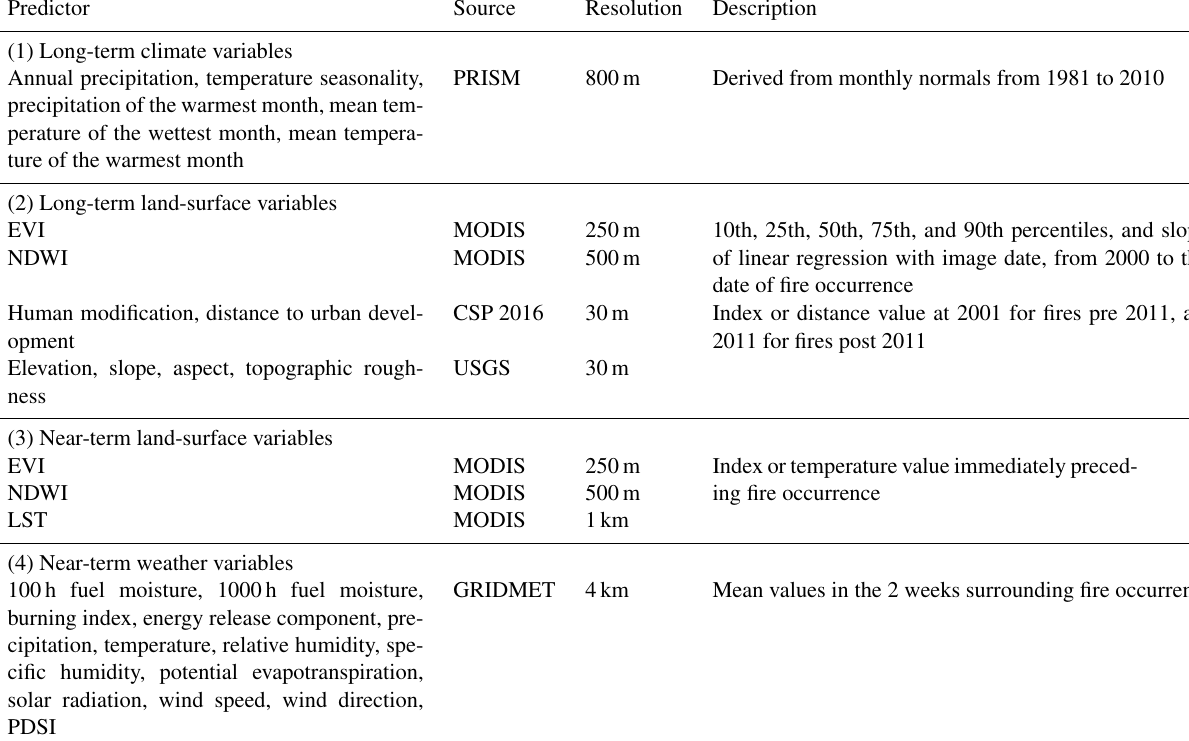
Table 1. Spatially explicit climate and land-surface predictors of conditional large fire probability, including the data source, spatial resolu- tion, and description of how variables were derived from the source data. Grouping of predictor variables indicates whether they are derived over the near term (months or weeks preceding fire occurrence) or long term